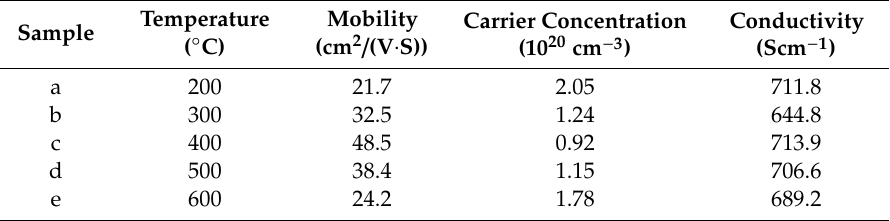
Table 2. Electrical properties of InN films on diamond substrates deposited at various temperatures. Sample